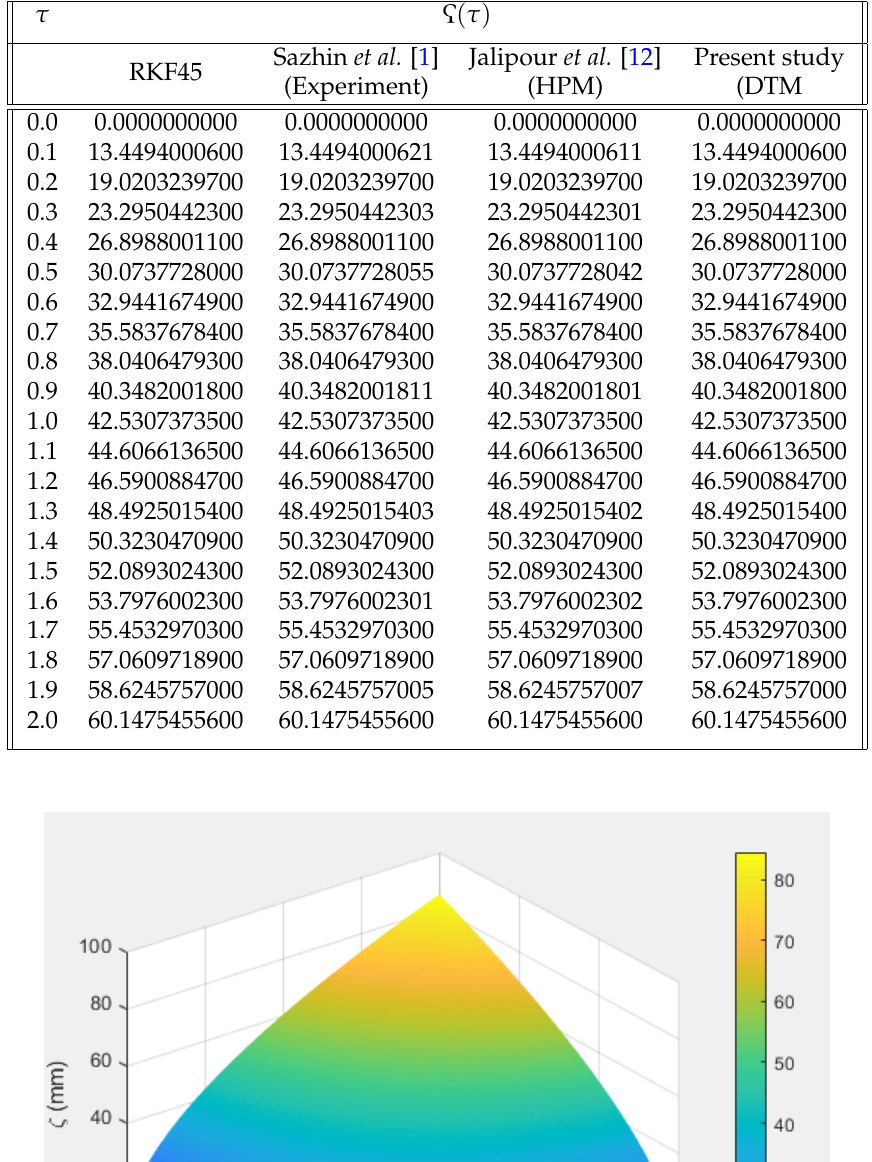
Table 2. Comparism and Validation of the analytical scheme